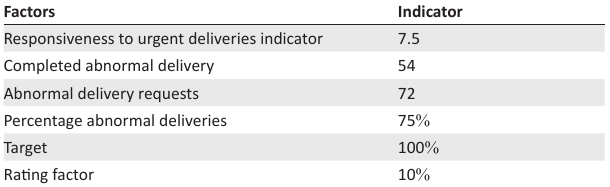
TABLE 19: Responsiveness to urgent